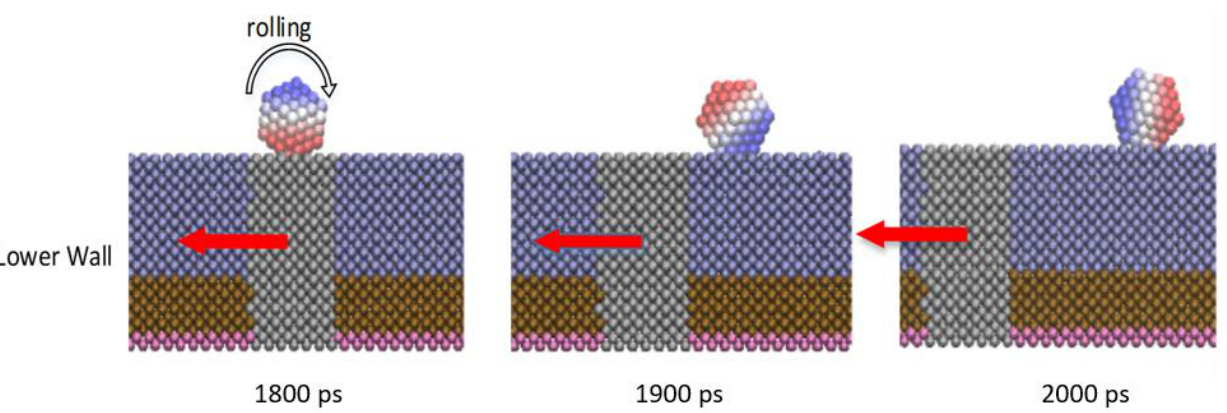
Figure 6. Snapshots of particle models under 0.25 GPa at the moment of 1800, 1900 and 2000 ps. Only the lower wall and one typical particle are shown. Atoms in the particle are colored by their Z position to demonstrate the rolling effect. Atoms in Gray are in the slice from 100 Å to 120 Å along the X direction. The red arrow indicates the slice movement.